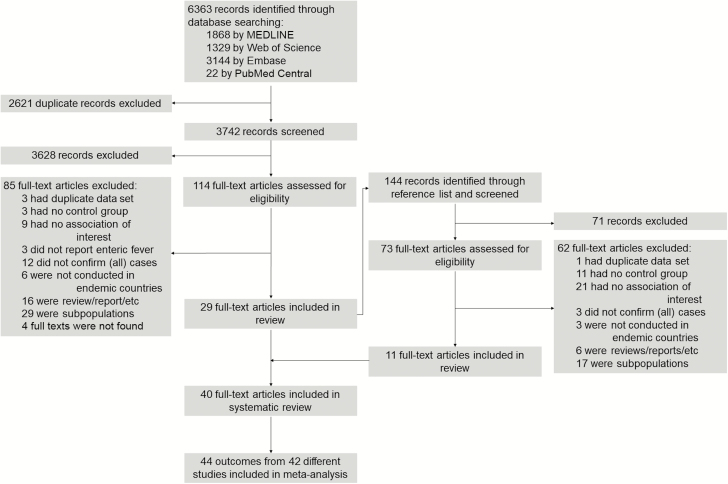
Flow diagram of the study selection process.